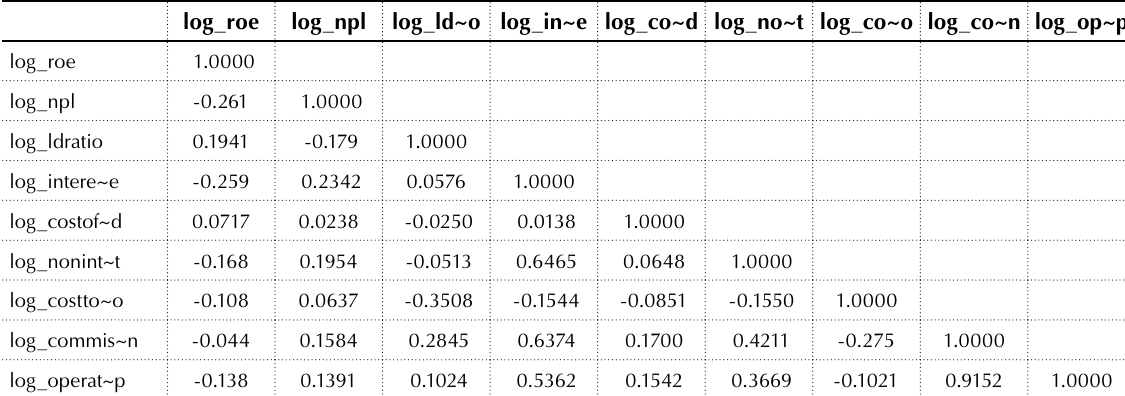
Table 8. Correlation matrix model